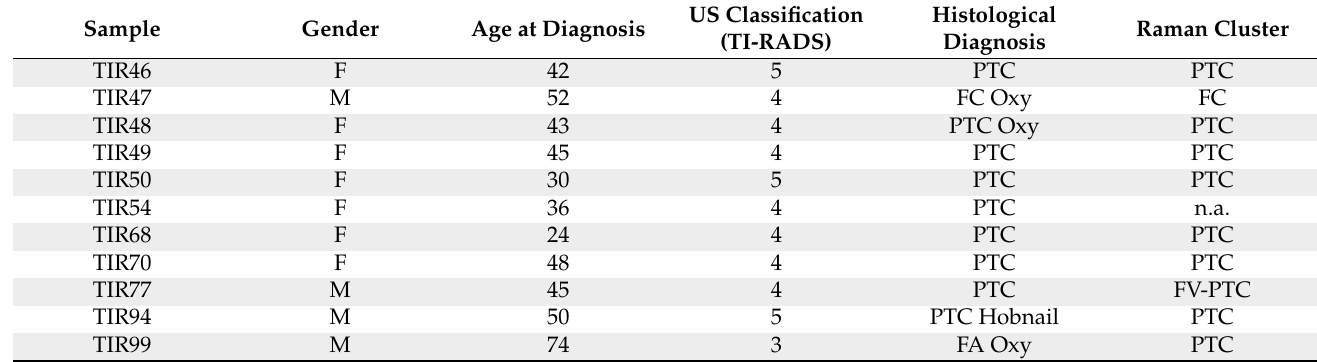
Table 1. List of all the patients investigated, along with clinical information. US Classification